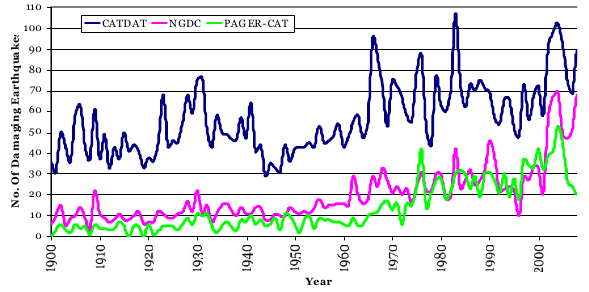
Fig. 4. A comparison of the number of damaging earthquakes in- cluded in major databases up to 2008 (CATDAT Damaging EQ Database v4.12, Daniell,